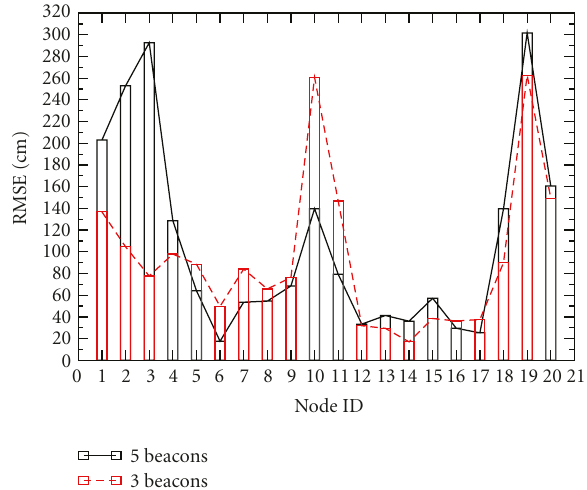
Figure 5: RMSE as a function of target position in the absence of priori information. N = 3 (tx1,tx3,tx5) and N = 5 beacons are considered.